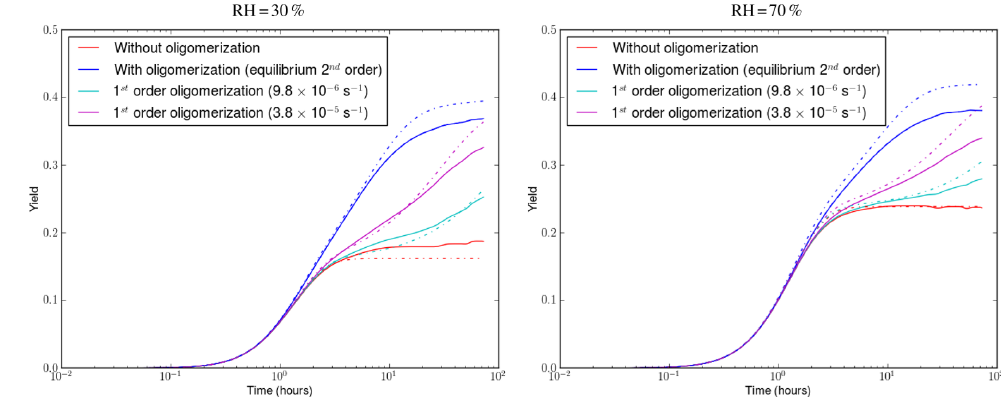
Figure 5. Evolution of the SOA yield from α -pinene oxidation as a function of time for an organic mass loading of 5µgm − 3 . Solid lines correspond to SOA formation with aging. Dashed-dotted lines correspond to SOA formation without aging.